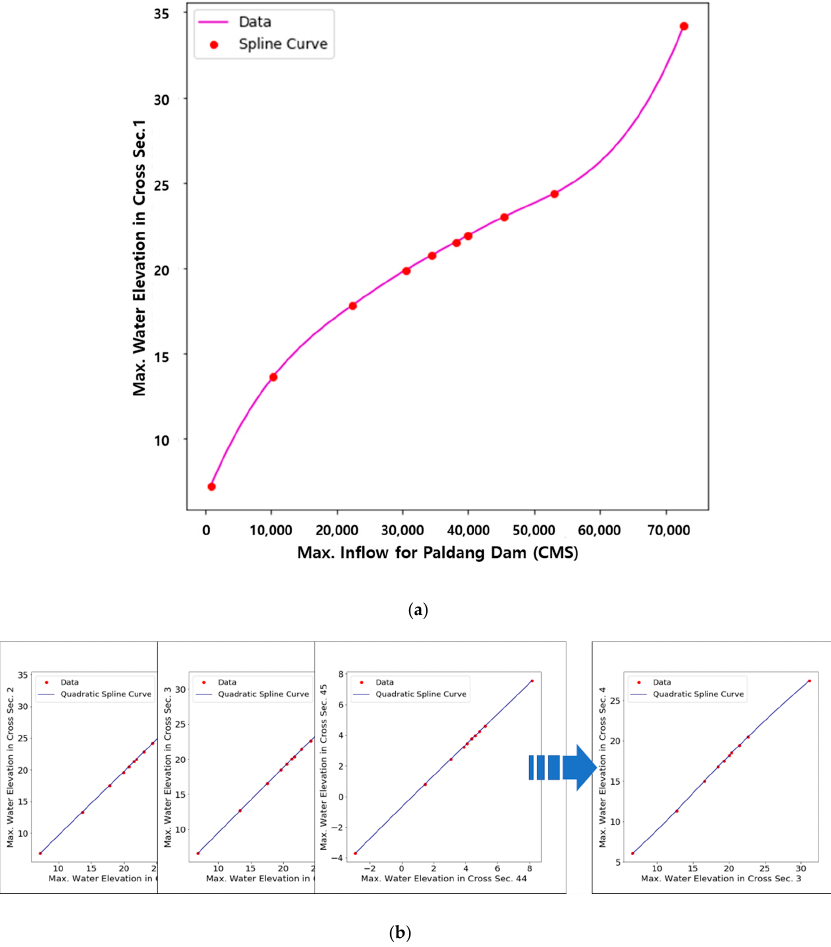
Figure 9. Spline curve for dam peak inflow and max water surface elevation. ( a ) Cubic spline curve; ( b ) quadratic spline curves.